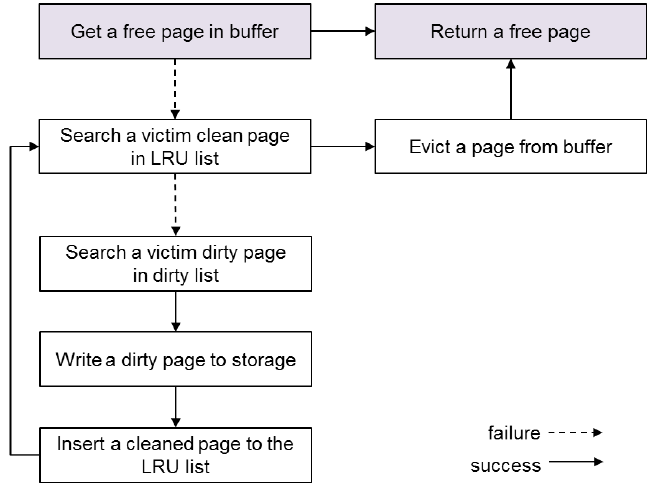
Figure 3. Memory reclamation scheme of SQLite.